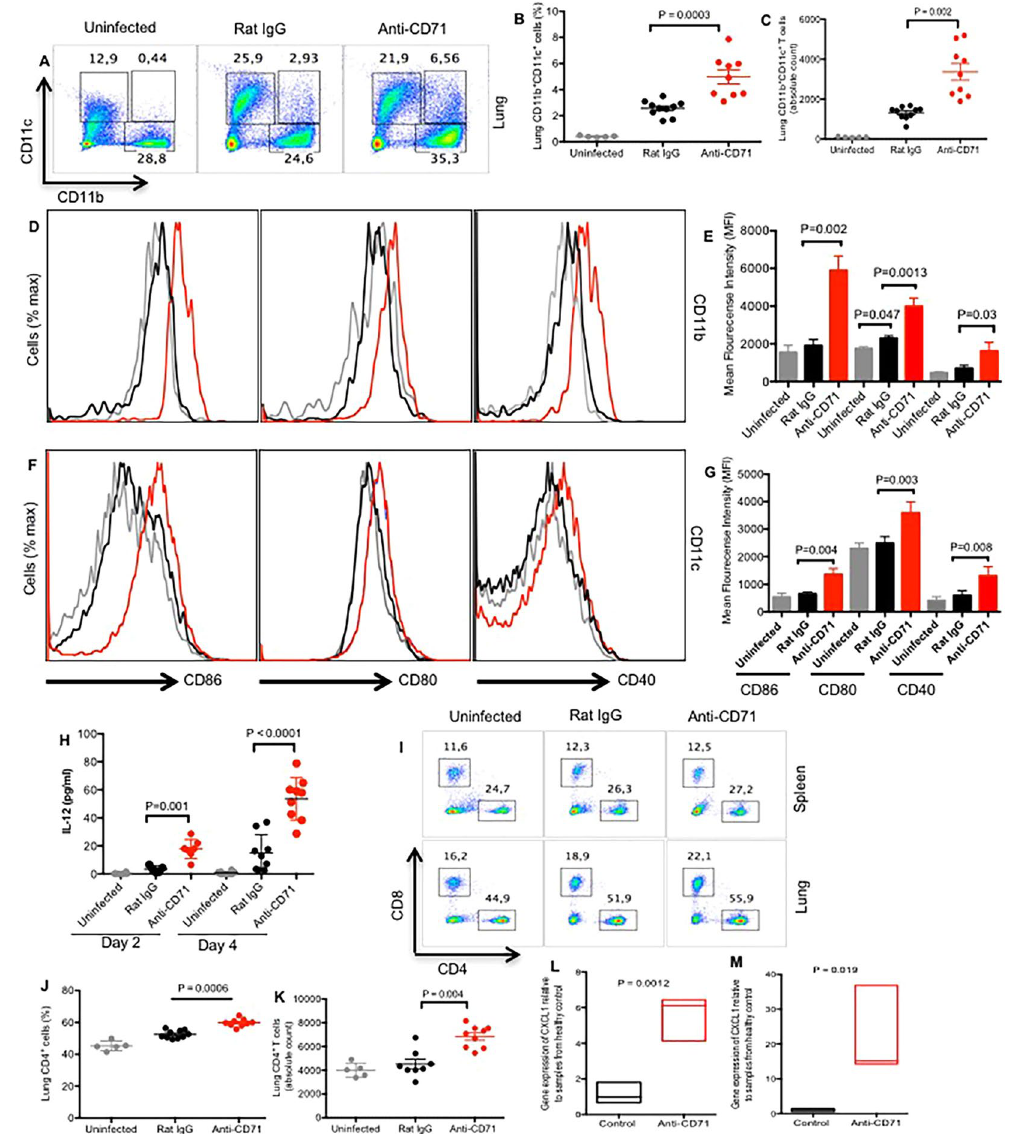
Figure 2. Deletion of CD71 + cells unleashes recruitment and function of immune cells in the lung in response to B. pertussis low dose infection. ( A ) Representative dot plots showing percentages of CD11b + , CD11c + and CD11b + CD11c + cells in the lungs of newborns day 2 post infection with B. pertussis . ( B,C ) Percentages and absolute number of CD11b + and CD11b + CD11c + cells isolated from the digested lung tissues obtained from the anti-CD71 treated versus isotype control at day 2 post infection. ( D–G ) Relative CD86, CD80, and CD40 expression by CD11b + or CD11c + cells recovered from the lungs at day 2 post infection, treated with anti-CD71 (red histograms gated on CD11b + or CD11c + cells) or isotype control antibody (black histograms gated on CD11b + or CD11c + cells) and uninfected mice (gray histograms gated on CD11b + or CD11c + cells) administered 200 μ g of each antibody at day 5. ( H ) IL-12 levels recovered from the lung homogenate of mice at day 2 and 4 post infection, treated with anti-CD71, isotype control antibody or uninfected mice. ( I ) Representative plots showing percentages of CD4 + and CD8 + T cells. ( J , K ) Percentages of CD4 + and CD8 + T cells from the digested lung tissues at day 2 post infection, either treated with anti-CD71 or isotype control compared with each other and uninfected mice. ( L , M ) CXCL-1 and CXCL-2 genes expression in the lungs of anti-CD71 or isotype control treated mice after B. pertussis infection compared with uninfected mice. Each point represents data from an individual mouse, representative of at least three independent experiments. Bar, mean ± one standard